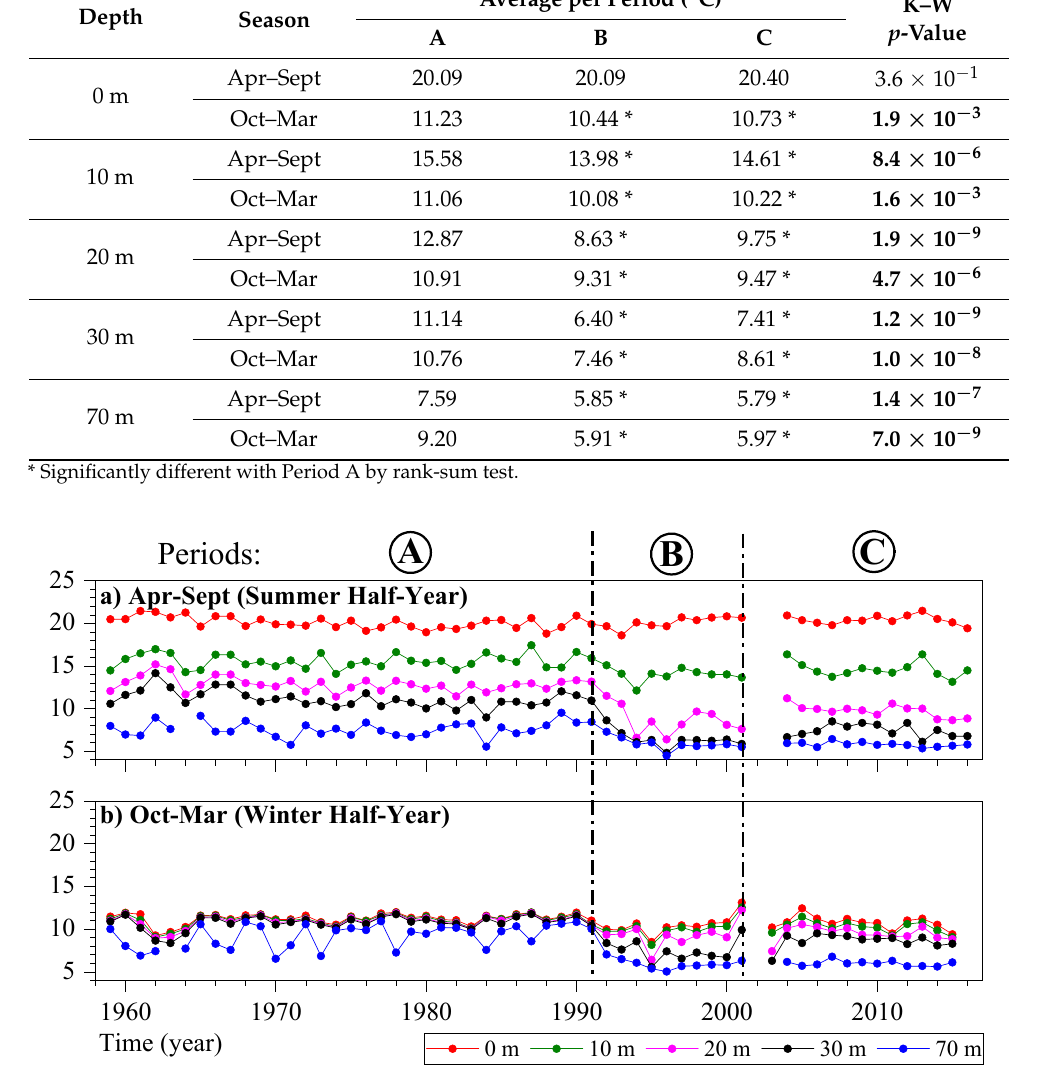
Table 3. Results of Kruskal–Wallis (K–W) and rank-sum tests at α = 0.05 for water temperatures at various depths. Significantly different p-values are in bold characters.